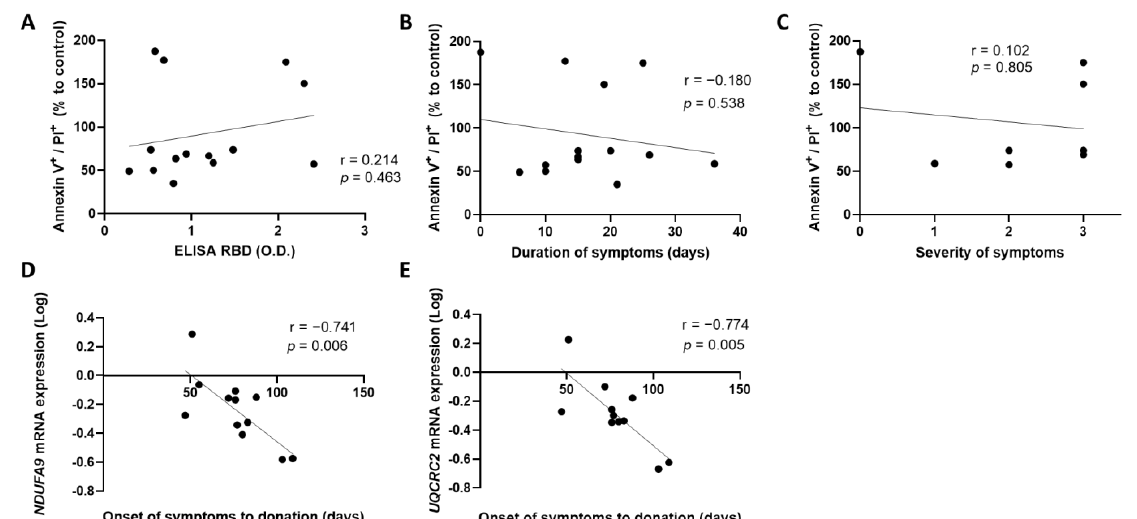
Figure 1. Clinical characteristics, cell death, and mitochondrial gene expression. Correlation between late apoptosis and ( A ) plasma anti-SARS-CoV-2 antibody concentration, ( B ) duration of symptoms of donors, and ( C ) severity of symptoms (from 0 to 3, 3 being the most severe) was assessed. The time from the onset of symptoms to donation was then correlated with the expression of ( D ) NDUFA9 and ( E ) UQCRC2 mRNA expressed by HCAECs. Data are represented as a relative percentage to cells treated with control plasma. Significance was determined by Spearman correlation. p ≤ 0.05 was considered significant. PI: propidium iodide; RBD: receptor binding domain; O.D.: optical density NDUFA9: NADH dehydrogenase 1 alpha subcomplex subunit 9; UQCRC2: cytochrome b-c1 complex subunit 2.